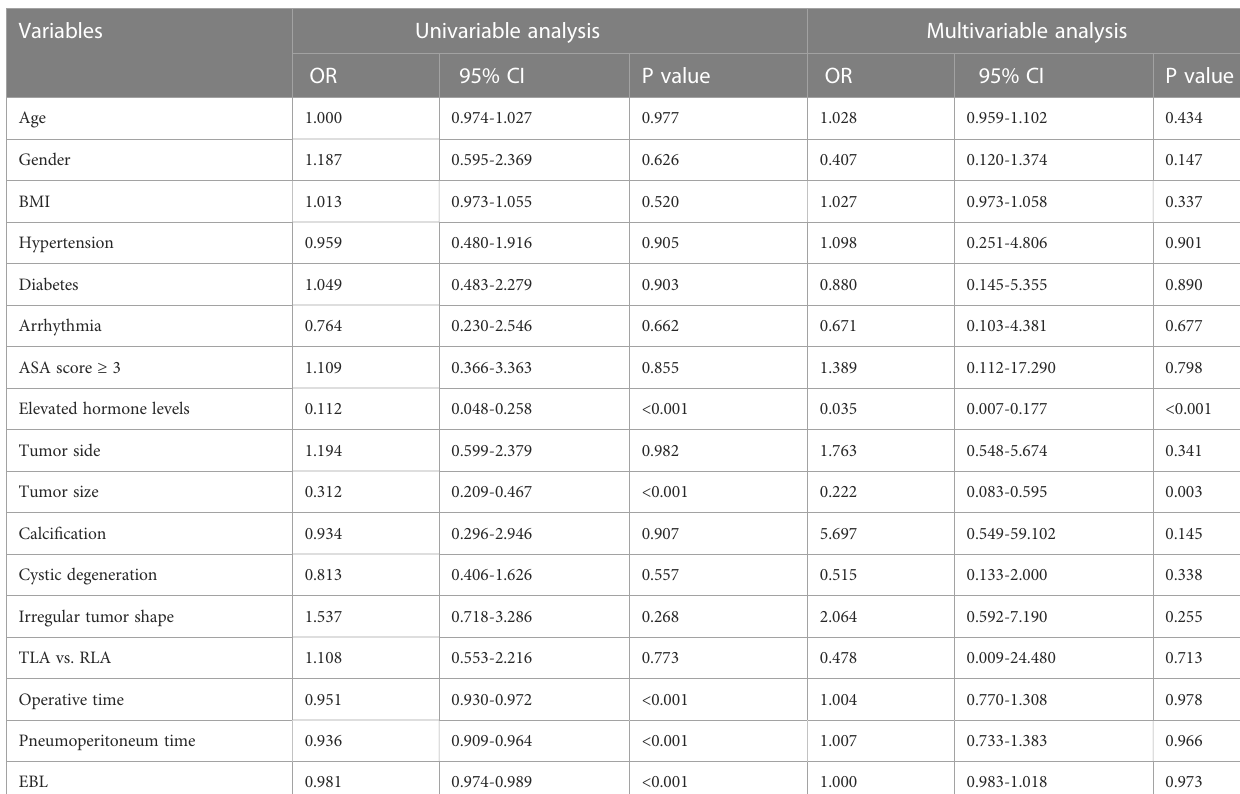
TABLE 3 Univariable and multivariable analysis for HI.